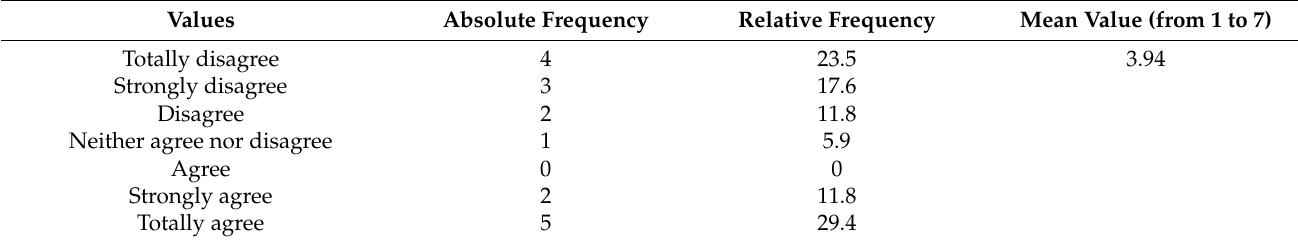
Table 3. Analysis of the results for item 3: “There are no more barriers for women than for men as members of university